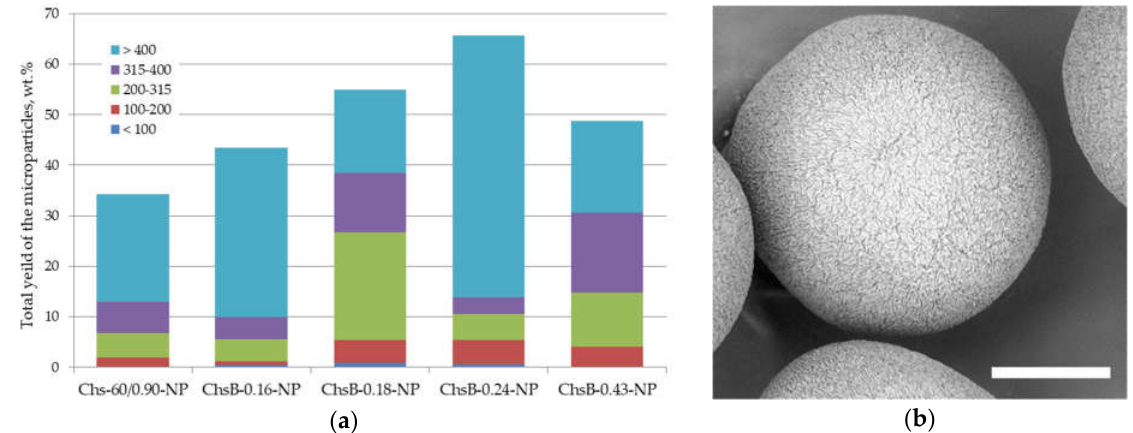
Figure 4. ( a ) Total yield and size distribution of PLA microparticles stabilized with nanoparticles obtained by the precipi- tation of 2% solutions of chitosan Chs-60/0.90-NP and its ChsB derivatives; ( b ) SEM micrograph of PLA microparticles stabilized with precipitated chitosan nanoparticles. The scale bar is 100 µm.